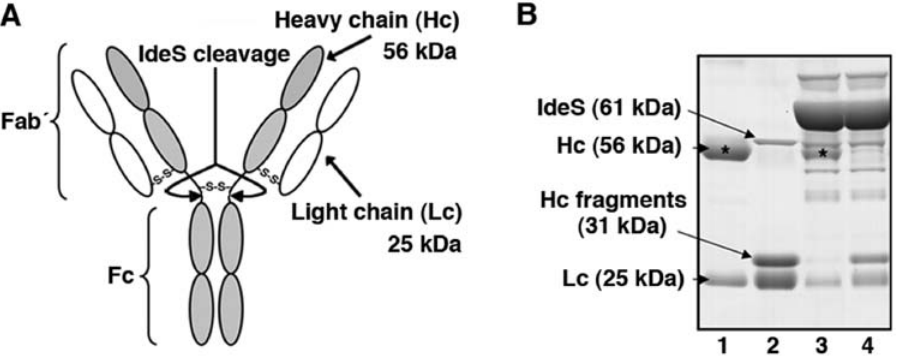
Figure 1. IdeS cleaves IgG in human blood. ( A ) Structure of IgG. The IdeS cleavage sites are indicated. ( B ) The following samples were separated by SDS-PAGE. Lane 1: Five m g of human polyclonal IgG in 10 m l PBS. Lane 2: Five m g of human polyclonal IgG and 1 m g of IdeS in 10 m l PBS (IgG and IdeS were preincubated for three hours at 37 u C before SDS-PAGE). Lane 3: Ten m l of plasma from human blood diluted 1:50 in PBS Lane 4: One hundred m l of human blood was preincubated with 1 m g of IdeS for three hours at 37 u C. The plasma from this sample (containing approximately